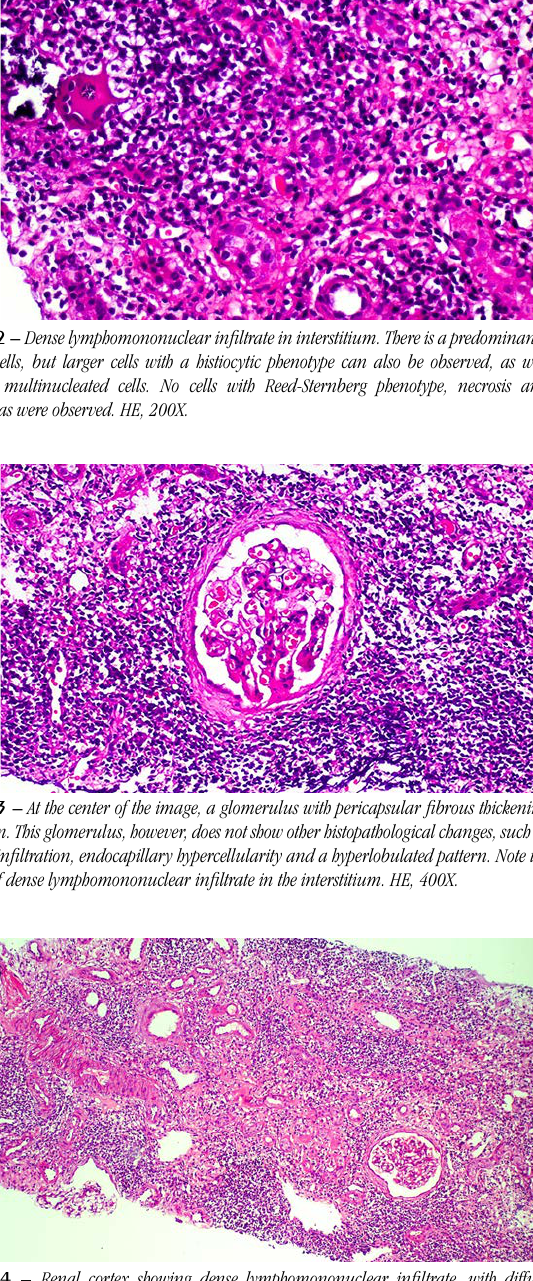
fIguRE 4 – Renal cortex showing dense lymphomononuclear infiltrate, with diffuse distribution throughout the sample sent for analysis. This infiltrate is not associated with significant interstitial edema. There are still tubules with an atrophic appearance and preservation of the architecture of sampled glomeruli. PAS, 200X.